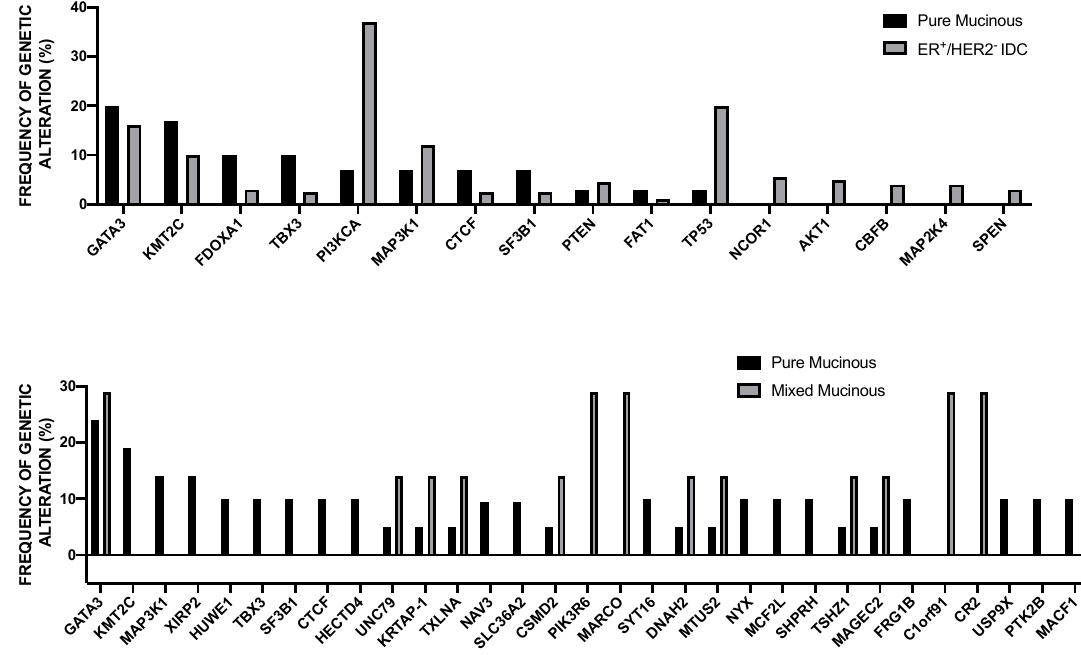
Figure 4. Landscape of somatic genetic alterations observed in mucinous breast cancer. Top panel: comparison of the frequency of most recurrent genetic alterations observed in pure mucinous breast cancers and ER + / HER2 - invasive ductal breast cancers. Bottom panel: comparison of the most frequent genetic alterations observed in pure mucinous and mixed breast cancers. The data shown in this Figure are reported by Pareja et al. 2019 [214].